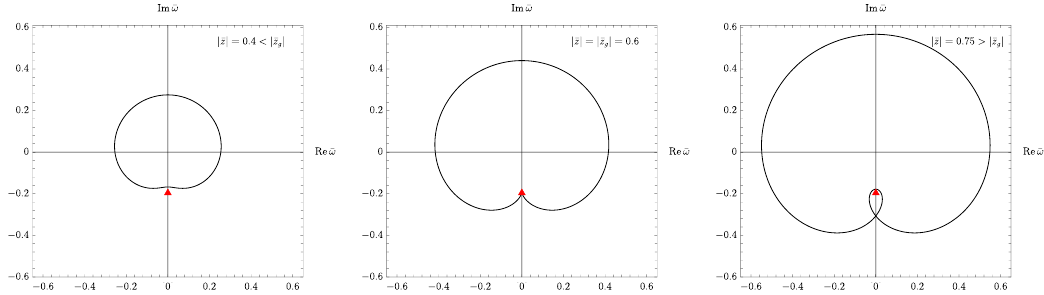
Figure 1 . Hydrodynamic sound dispersion relation ¯ ω (¯ z ) , where ¯ ω ≡ ω/ (2 πT ) and ¯ z ≡ z/ (2 πT ) , in the N = 4 SYM theory showing the development of a cusp at ¯ z = ¯ z g = − 0 . 603 i . The curve is formed by writing ¯ z = | ¯ z | e iφ and varying φ ∈ [0 , 2 π ] . The value of ¯ ω (¯ z g ) is depicted with a red triangle. After the formation of the cusp (i.e., for | z | > | z g | ) the curve has a